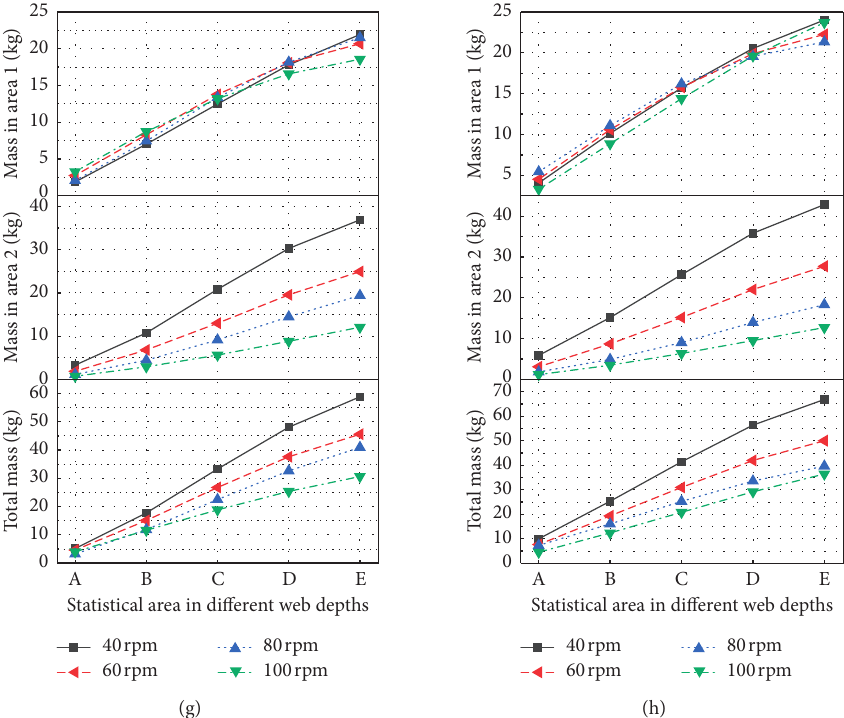
Figure 12: Cumulative mass of coal particles in different statistical areas: (a) drum I, (b) drum II, (c) drum III, (d) drum IV, (e) drum V, (f) drum VI, (g) drum VII, and (h) drum